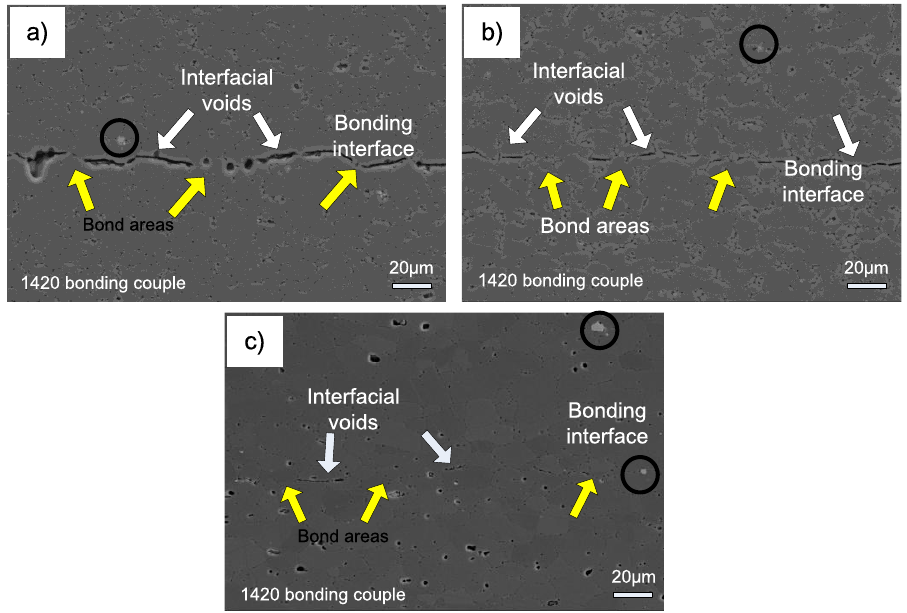
Figure 7. SEM images of the 1420-1420 interface characteristics after bonded at different temperatures: ( a ) 460 °C; ( b ) 490 °C; (c) 520 °C.